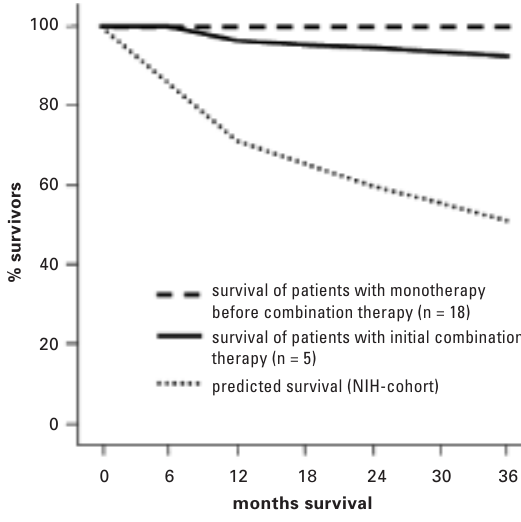
Figure 4 Survival of present cohort compared with predicted sur- vival (NIH-cohort, Alonzo et al.